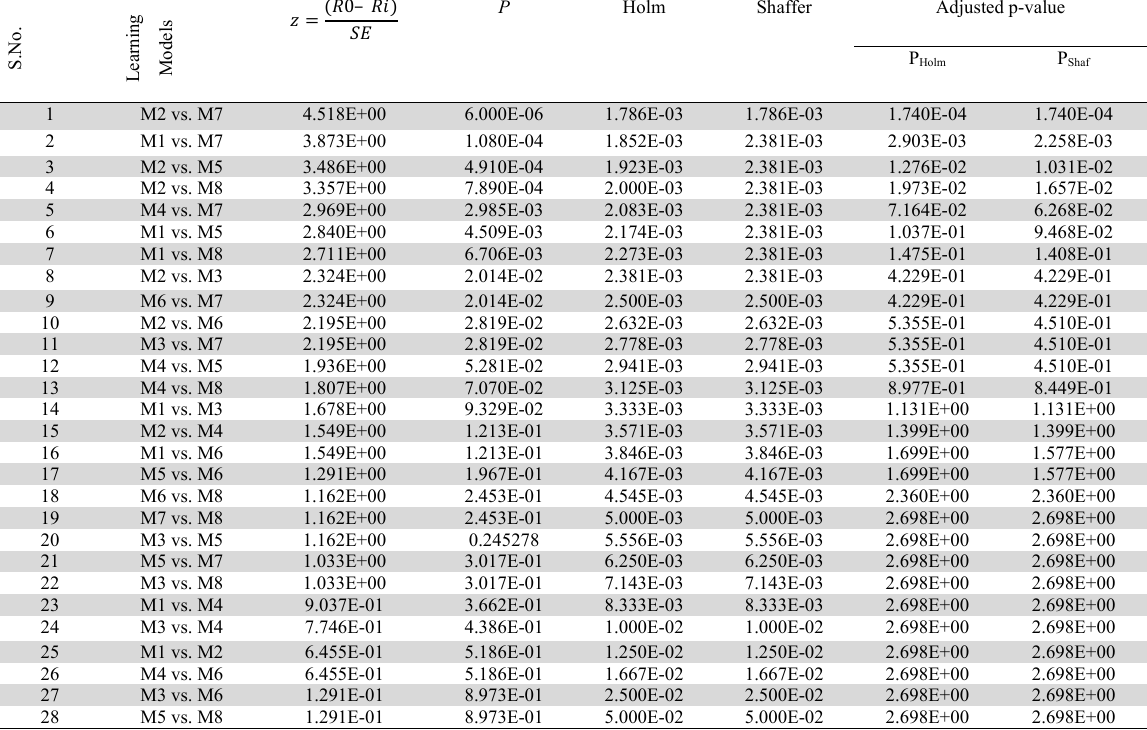
Table 5 Adjusted p-value and p-value for post-hoc multiple comparisons of different models at significance level α =0.05 for experienced group N o S .